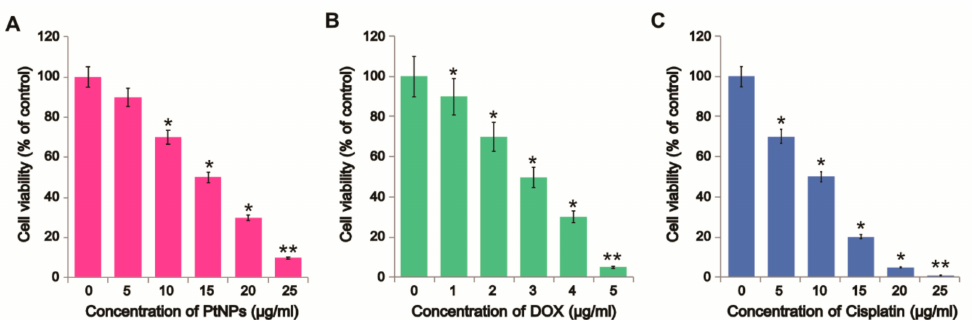
Figure 2. Dose-dependent e ff ect of PtNPs, DOX, and CIS on U2OS cell viability. U2OS cell viability determined after exposure to di ff erent concentrations of ( A ) PtNPs (5–25 µ g / mL), ( B ) DOX (1–5 µ g / mL), or ( C ) CIS (5–25 µ g / mL) for 24 h. Results are expressed as the mean ± standard deviation of three independent experiments. Di ff erences between the treated and control groups were measured using Student’s t -test and statistically significant di ff erences are indicated by * ( p < 0.05). * p < 0.05 was considered significant; ** p < 0.01 was considered highly significant and *** p < 0.001 was considered very highly